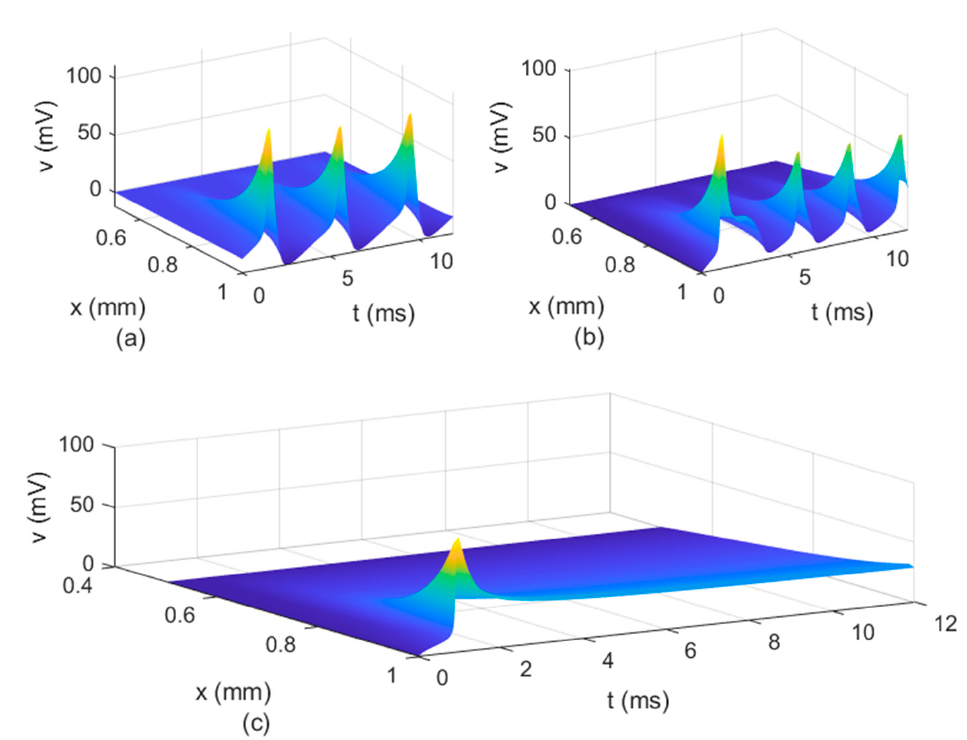
Figure 10. Spatio-temporal variations of voltage 𝑣(𝑥, 𝑡) for ( a ) 𝛽 = 1 , ( b ) 𝛽 = 0.8 , and ( c ) 𝛽 = 0.66. Here, 𝑝 = 0.25, 𝑞 = 0.75, and 𝛼 = 0.65 .